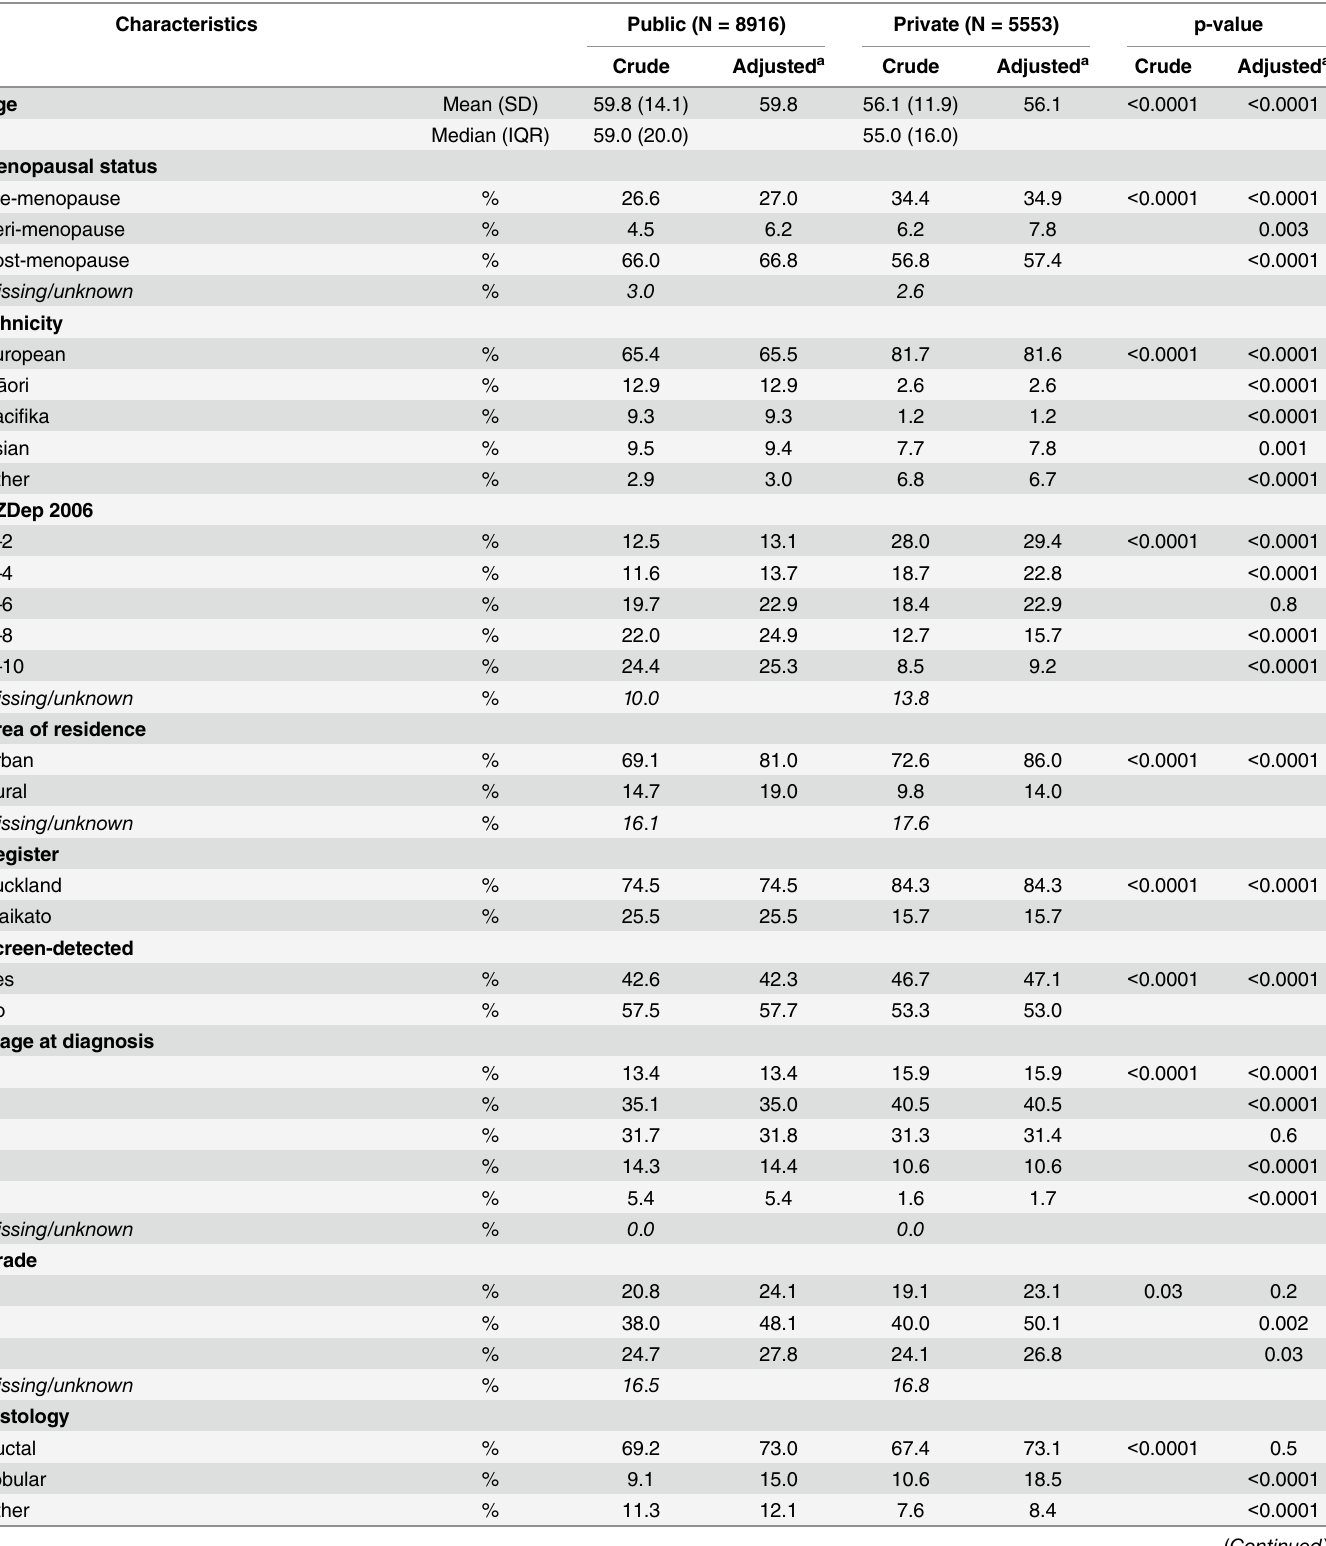
Table 1. Baseline characteristics by health care facility